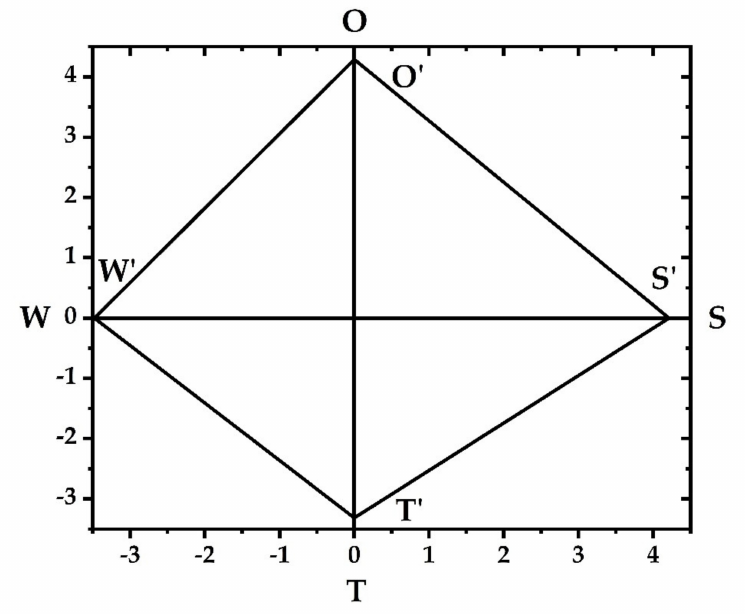
Figure 2. SWOT strategic quadrilateral.